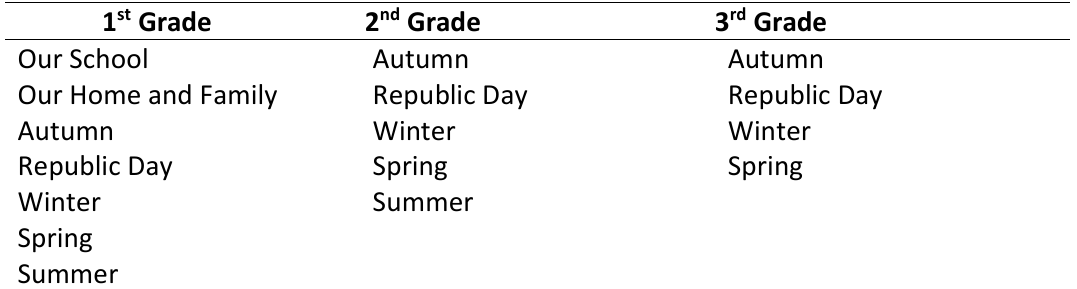
Table 2. Units of the Life Studies course by grade